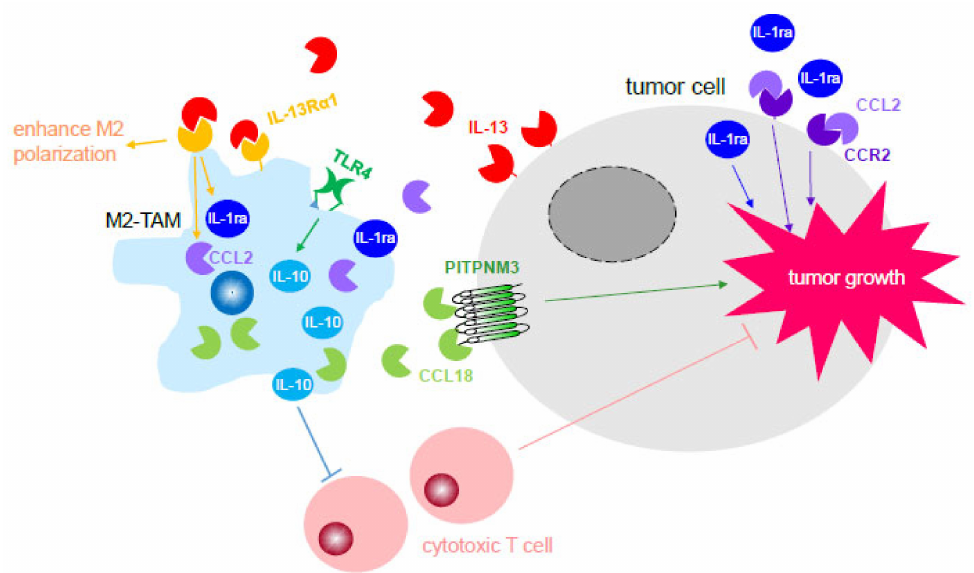
Figure 1. M2-tumor-associated macrophage (M2-TAMs) potentiate tumor growth through their secreted cytokines. Cytokines released by M2-TAMs participated in enhancing tumor growth through an increase in proliferation and inhibition of tumor-killing immune cells, such as cytotoxic T cells. Tumor cells also produce certain cytokines, such as IL-13, that contribute to the polarization of macrophages to become M2-TAMs, thus generating a positive-feedback loop between M2-TAMs and tumor cells during tumor progression. Abbreviation, IL-1ra: interleukin 1 antagonist; IL-10: interleukin-10; TLR4: